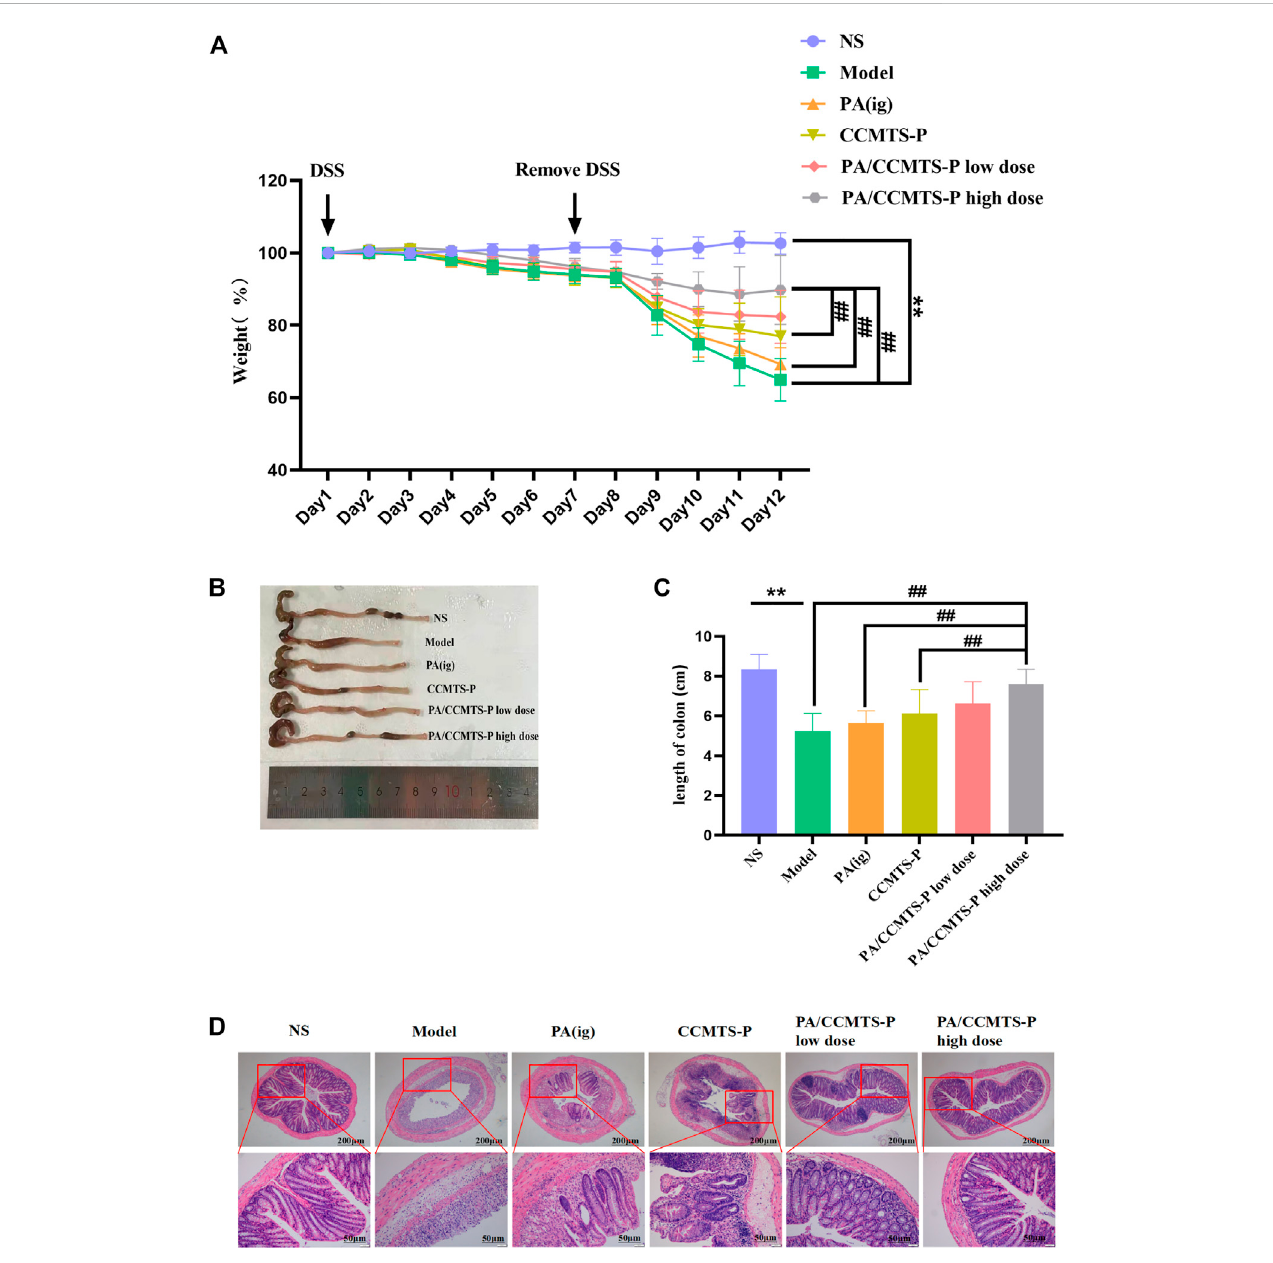
FIGURE 4 PA/CCMTS-Pmarkedlyameliorates thepathological symptoms ofDSS-induced UCmice. (A) The body weight change ofmice in each group during the experiment from Day1 to Day 12. (B) Representative colon images at day 12. (C) Statistical graph of colon length in each group on Day 12 ( n = 6). (D) Representative images of H and E staining of the colon tissue of mice in each group. Scale bars, 200 and 50 μ m. Data are shown as mean ± SD ( n = 6), ** p < 0.01, # p < 0.05, ## p <